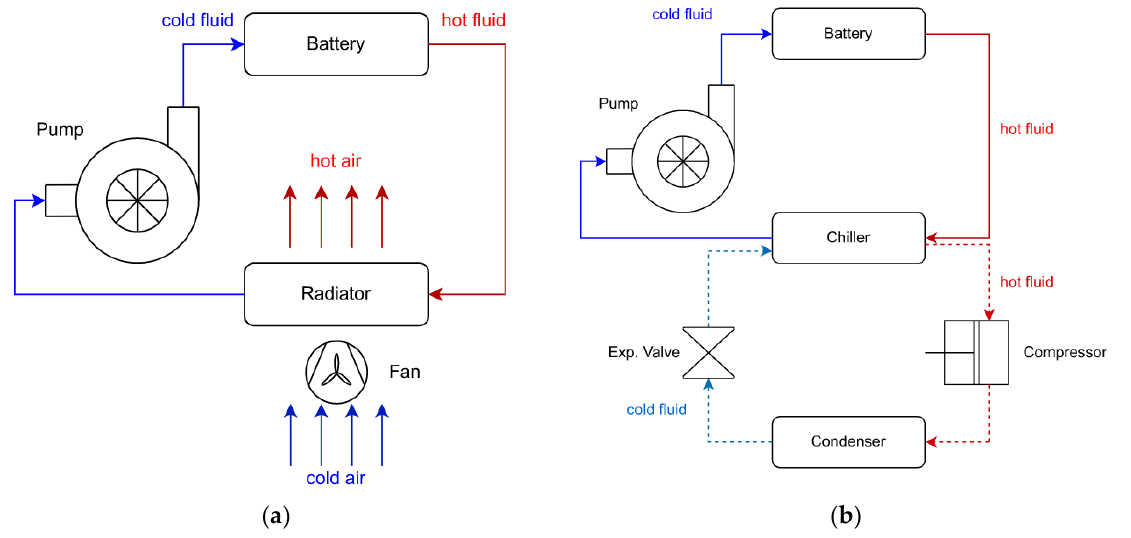
Figure 4. Liquid cooling system types: ( a ) radiator-based and ( b ) refrigeration-based.